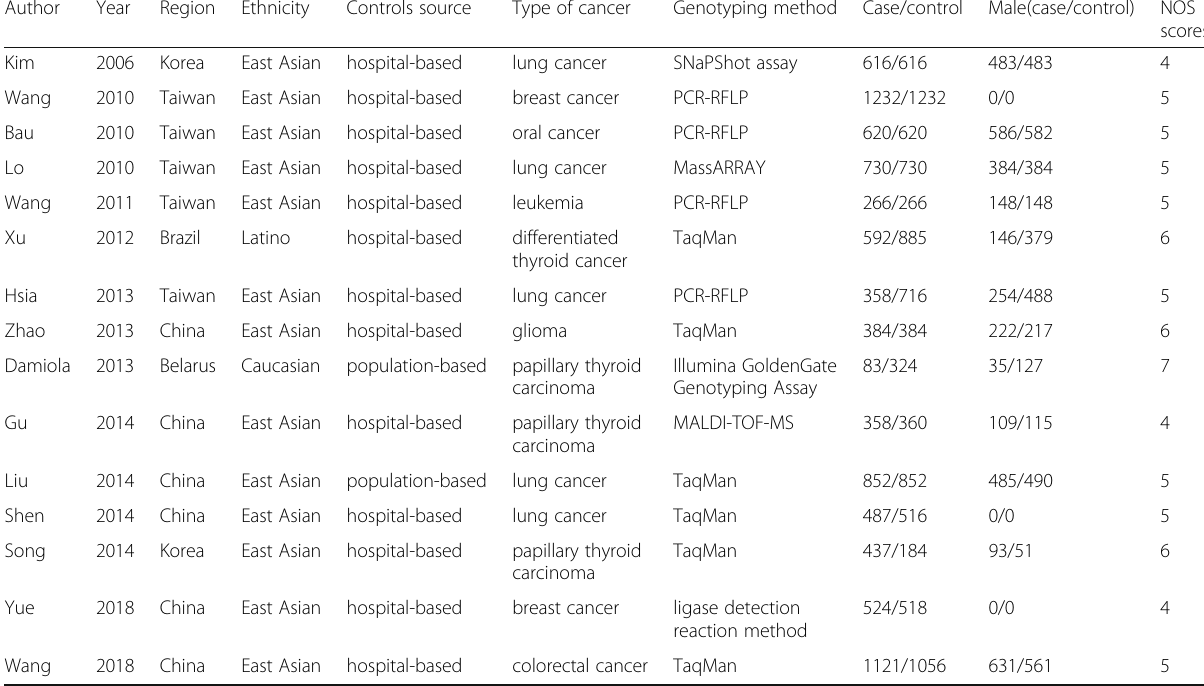
Table 1 Baseline characteristics of qualified studies in this meta-analysis